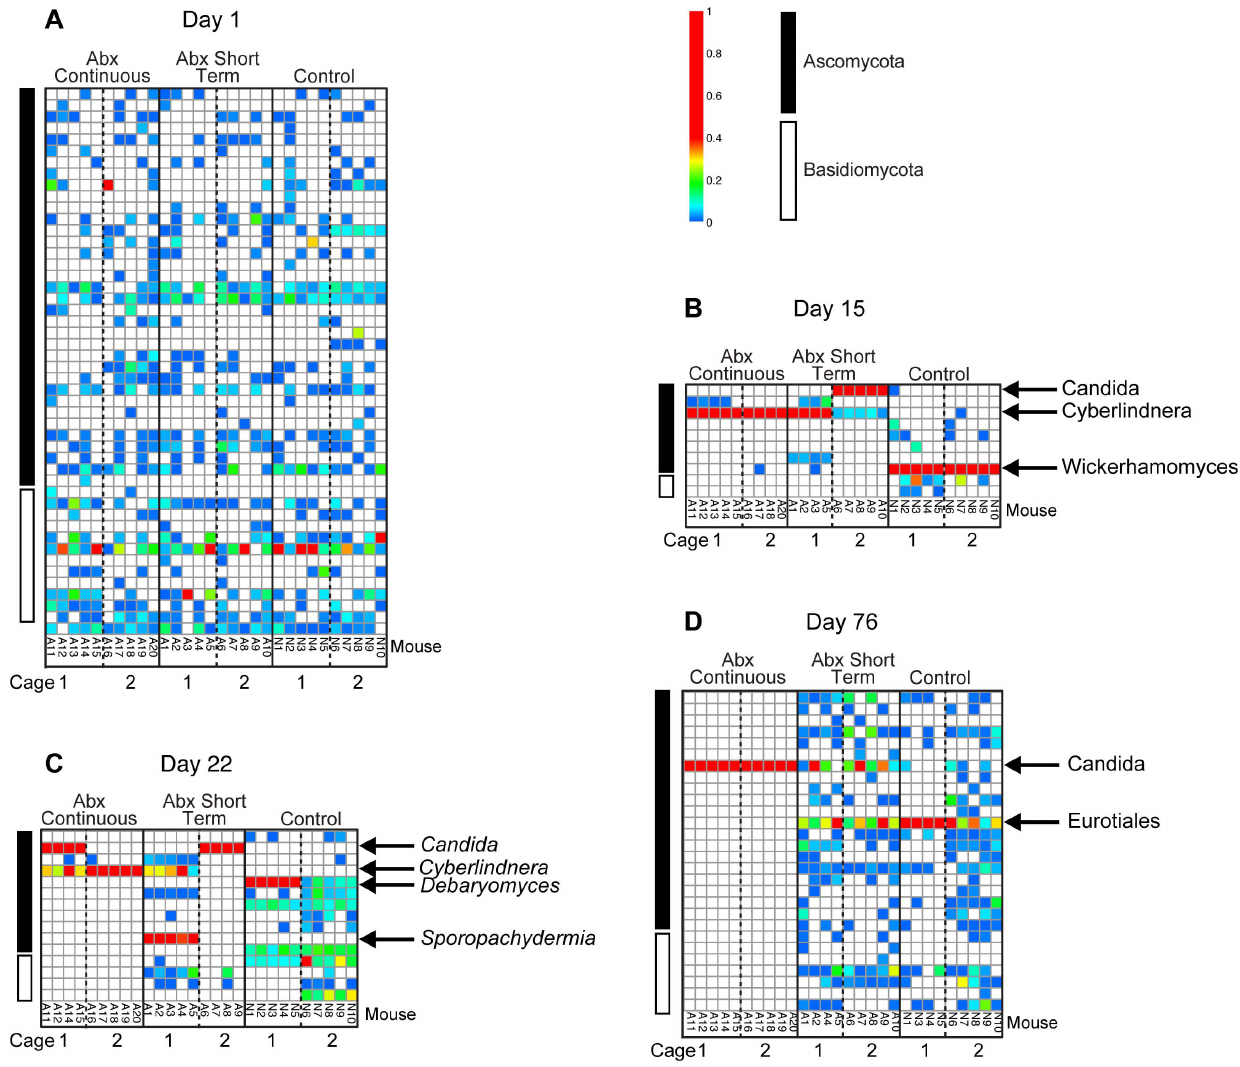
Figure 6. Longitudinal analysis of fungal lineages inferred from ITS rRNA gene sequencing. Fungal lineages detected are summarized in heat map format. Data for four days are shown (days 1, 15, 22, and 76). Each column indicates a single mouse. The groups tested are indicated at the top of the columns. The ten mice in each of the three treatment groups were each housed in two cages of five each. The distribution of mice in cages is indicated at the bottom of the columns. The day of treatment is indicated at the top. The color codes at the top right indicate the proportions and Phyla of origin.